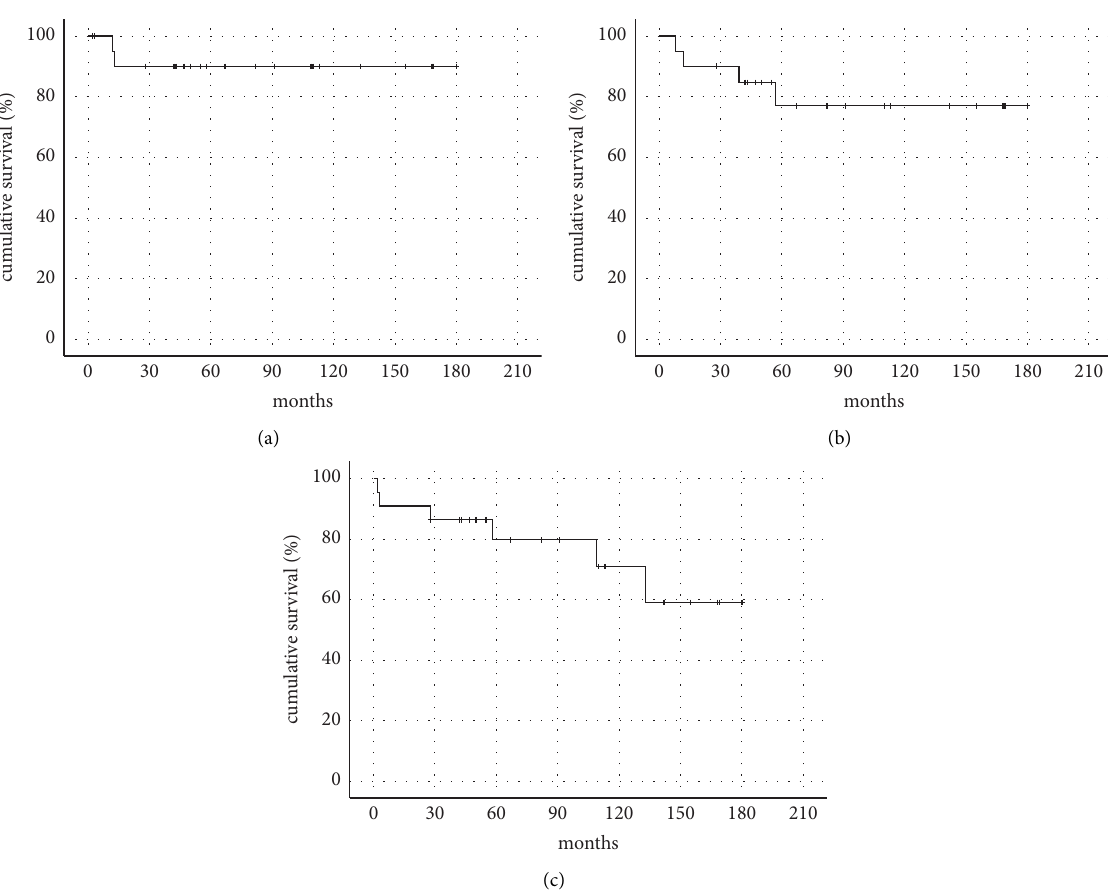
Figure 3: Te Kaplan-Meier survival curve of recurrence-free (a), metastasis-free (b), and overall survival (c). Te estimated 5-year survival rate is 90.0% (a). 77.0% (b) and 79.7% (c),